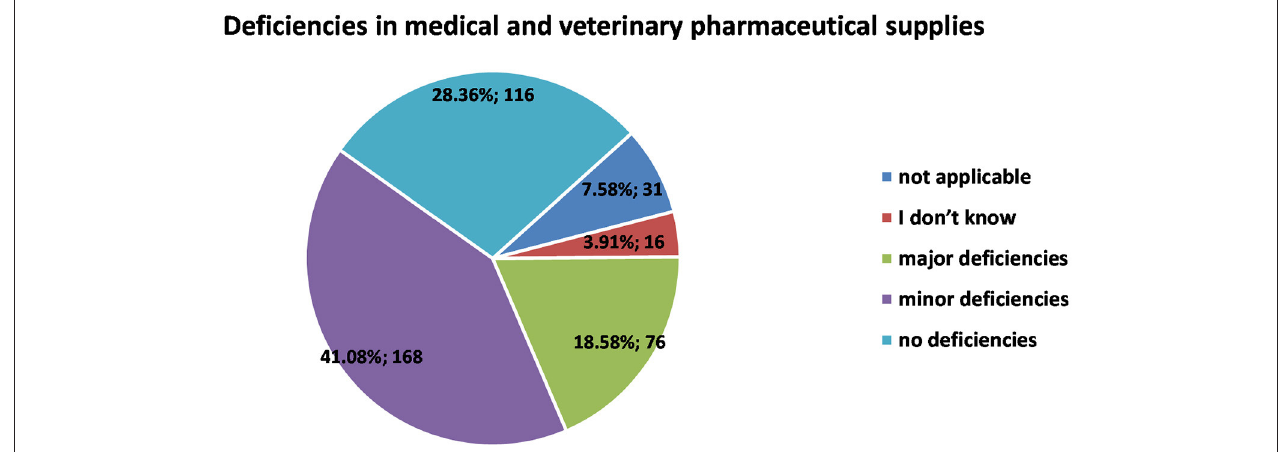
FIGURE 2 | Distribution of respondents ( n = 407) with respect to the encountered deficiencies in medical and veterinary pharmaceutical supplies at the workplace during confinement.